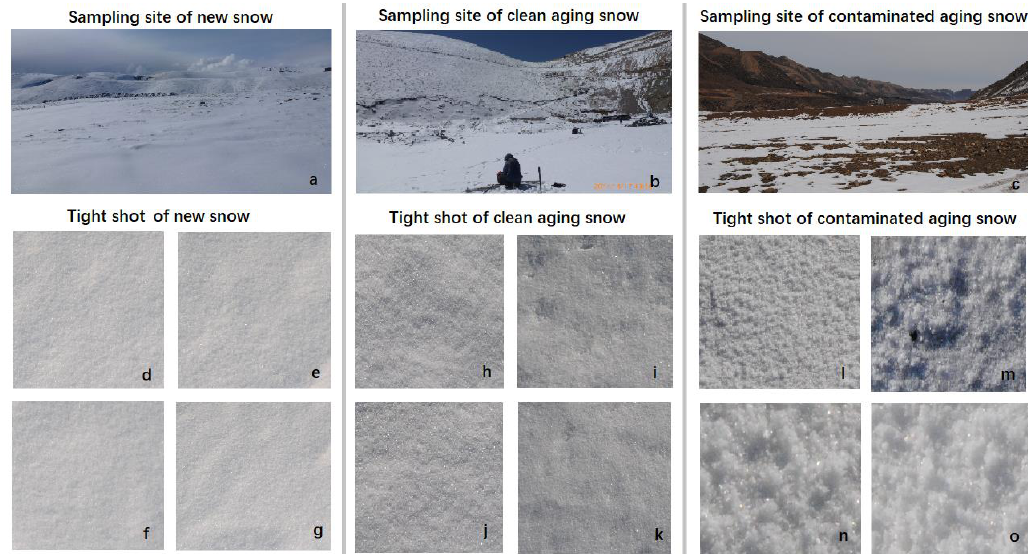
Figure 3. Photographs of infield sampling sites of ( a ) new snow, ( b ) clean aging snow, and ( c ) contaminated aging snow and the tight shots of ( d – g ) fresh snow, ( h – k ) clean aging snow, and ( l – o ) contaminated aging snow with soot.